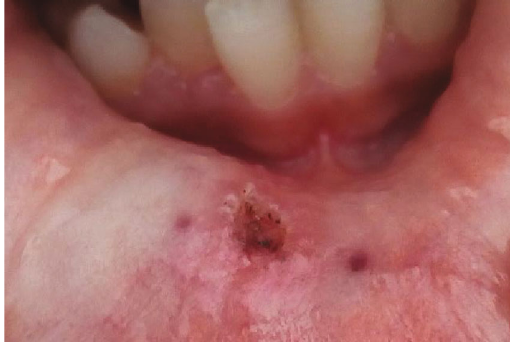
Figure 5: After2weeksoffollow-up: fi brinnetworkrecoveredthesite.